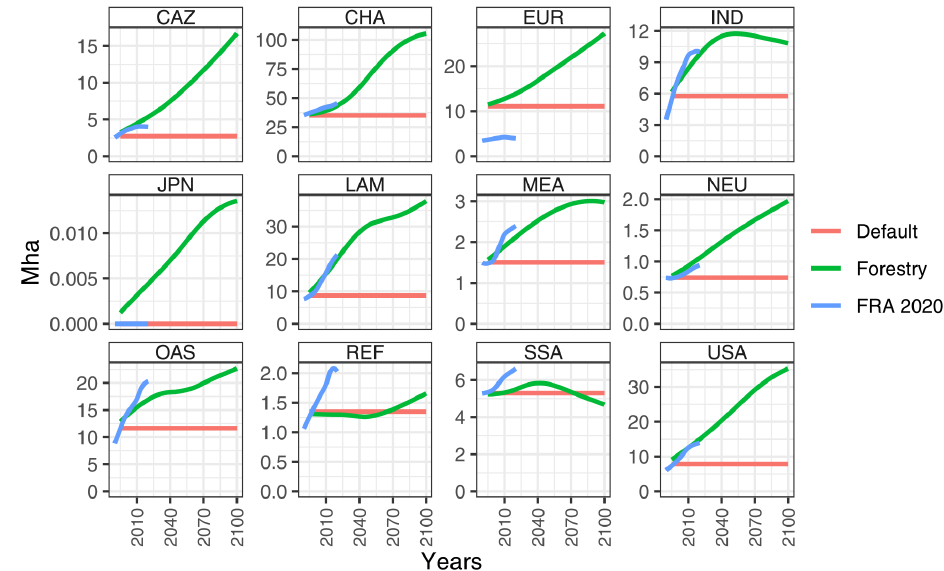
Figure A1. Regional development of plantation area for 1995–2100 in the SSP2 scenario.